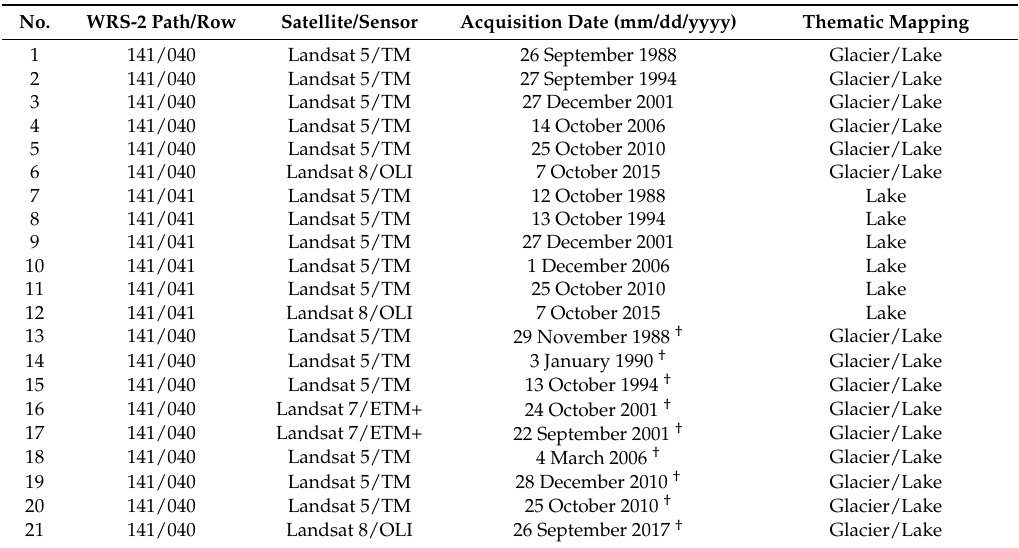
Table 1. Landsat images applied for glacier and glacial lake